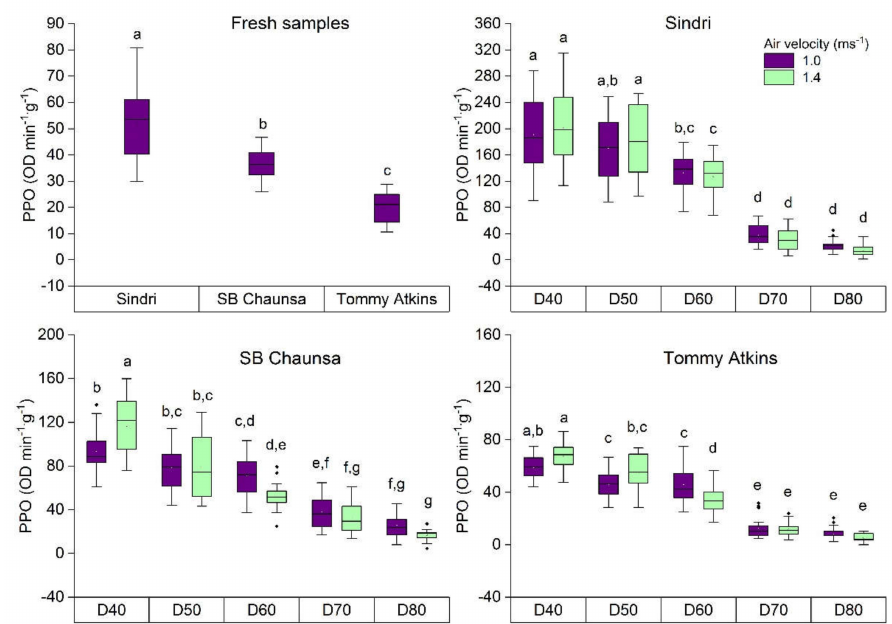
Figure 2. Polyphenol oxidase (PPO) activity in fresh and dried mango of the varieties Sindri, SB Chuansa, and Tommy Atkins; D = dried samples at temperatures 40 ◦ C to 80 ◦ C. a–g values with di ff erent letters in the box plot indicate the significant di ff erence p < 0.05, ( n = 20 ×